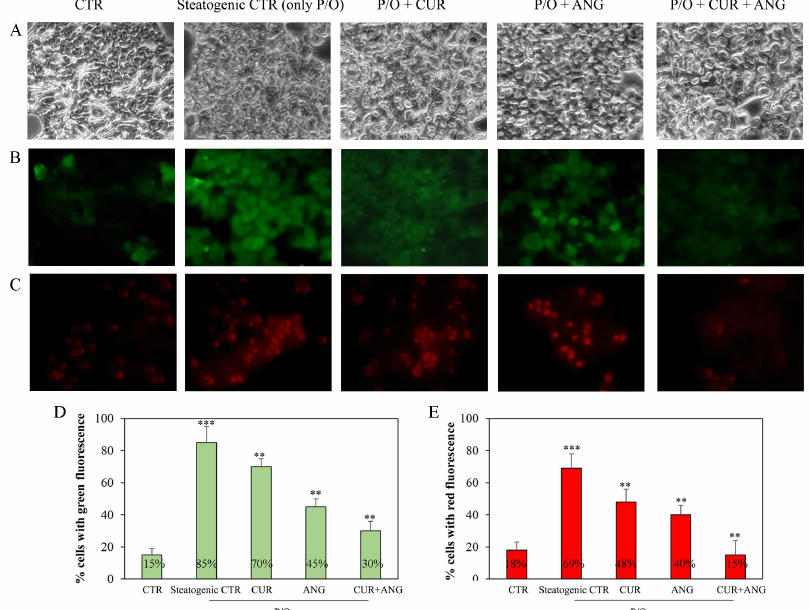
Figure 4. Andrographolide–curcumin association reduced intracellular ROS production on HepG2 cells after steatosis induction (P/O) for 24 h as reported in Section 4. ( A ) Cells observed under light microscopy. Intracellular ROS were detected using ( B ) H 2 DCFDA or ( C ) DHE staining as